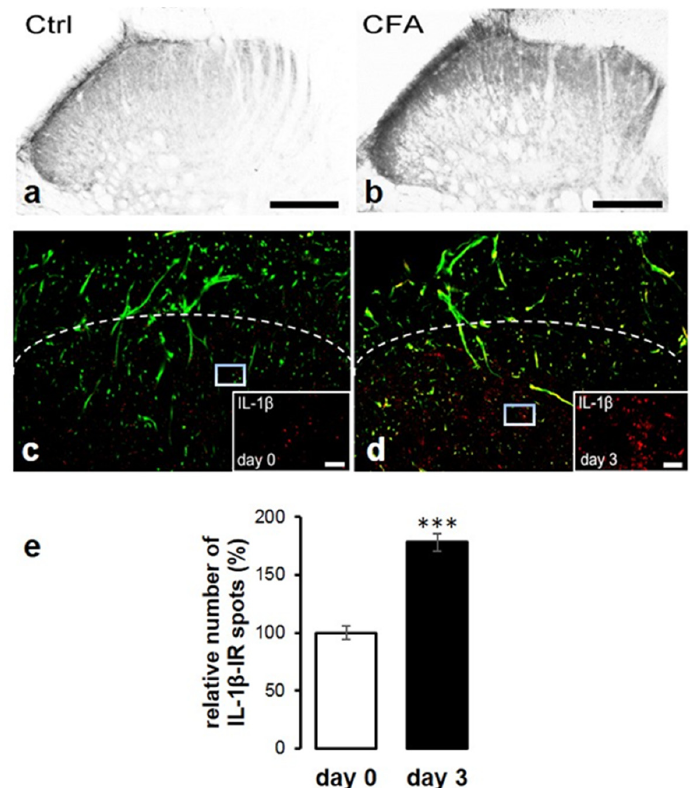
Figure 2. CFA-evoked inflammation of the hind paw initiates overproduction of IL-1 β protein in the superficial laminae of the spinal dorsal horn of rats. ( a ) In control animals (Ctrl), a moderate immunoperoxidase reaction of IL-1 β was observed in the superficial spinal dorsal horn, while almost no immunolabelling was present in deeper laminae. ( b ) In CFA-administered animals (CFA), a substantially higher immunoreactivity was detected. Scale bars: 200 μ m. ( c , d ) Representative confocal images from superficial spinal dorsal horn show increased number of IL-1 β immunoreactive puncta (red) upon CFA injection (day 3). Dashed line indicates the transition between the spinal white and gray matter. Green color shows GFAP labelling. Scale bar: 5 μ m. ( e ) Quantitative analysis of confocal images showing significant elevation of IL-1 β + puncta ( p = 0.0000064) on day 3. Data are shown as mean ± SEM. *** p < 0.001.